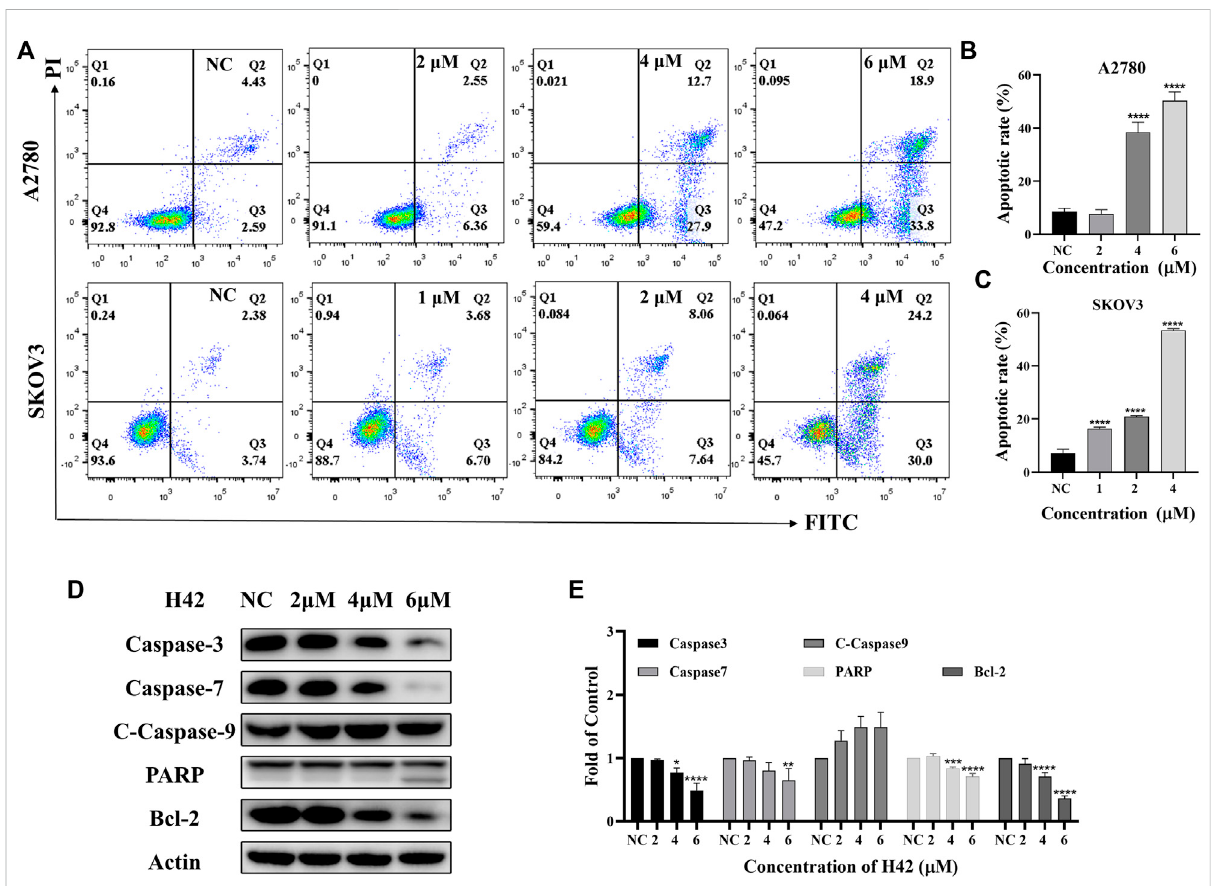
FIGURE 4 CompoundH42inducedapoptosisinA2780andSKOV3cells.A2780andSKOV3cellsweretreatedwithvariousconcentrationsofH42for72H. (A) ApoptosisofcellsweredeterminedbyAnnexinv-FITC/PIdouble-staininganalysisusingFCMand (B – C) analyzedbypercentage. (D) Expressionof apoptosis-related proteins in A2780 was measured by Western blot and (E) analyzed in the density ratio. Data are all represented as mean ± SD of at least three independent experiments. * p < 0.05, ** p < 0.01, *** p < 0.001, and **** p < 0.0001 were compared with the